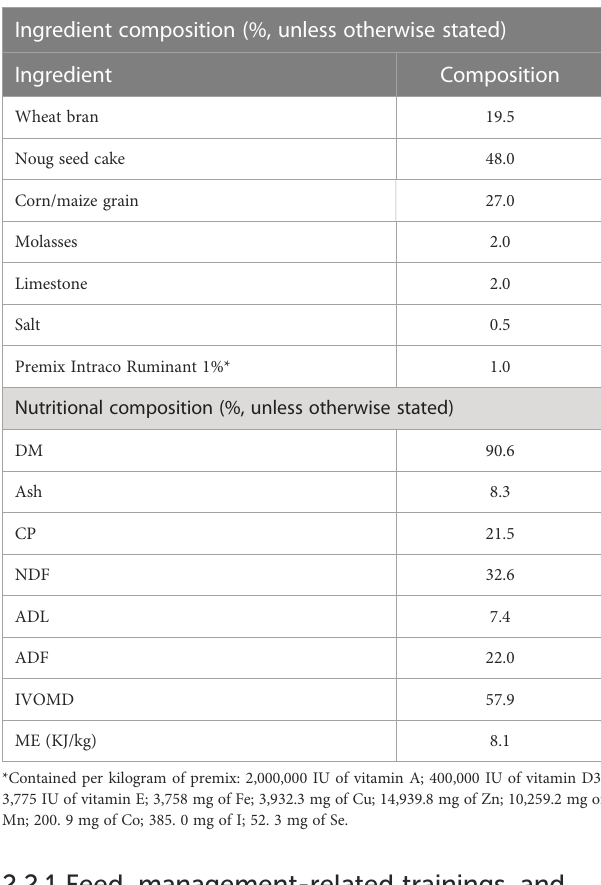
TABLE 1 Ingredient and nutritional composition of concentrate feed.